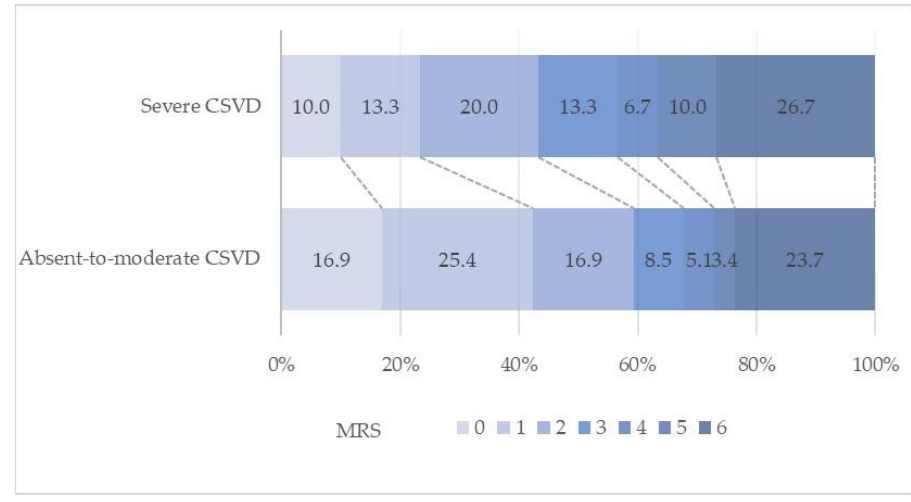
Figure 2. Distribution of 90 d modified Rankin scale (mRS) scores according to CSVD burden. Early neurological recovery was observed in 59 of 100 patients (59.0%) with available data, 24 patients (24.0%) with absent-to-moderate CSVD, and 17 patients (17.0%) with severe CSVD. Table 3 shows the outcomes of patients with absent-to-moderate CSVD or severe CSVD, and 41% of the patients had a primary outcome of poor mRS, 33% had sICH, 18% had END, 14% underwent MCE, and 4% died during admission. Univariable analysis demonstrated that there was no statistically significant interaction between the CSVD burden and functional outcome (OR: 1.907, CI: 0.784, 4.642). A severe CSVD burden was not significantly associated with primary and secondary outcomes in univariate or multivariate regression models. Table 3. Univariate and multivariate logistic regression for the outcomes by severe CSVD. Multivariate Analysis Univariate Analysis Model 1 Model 2 OR (95%CI) OR (95%CI)